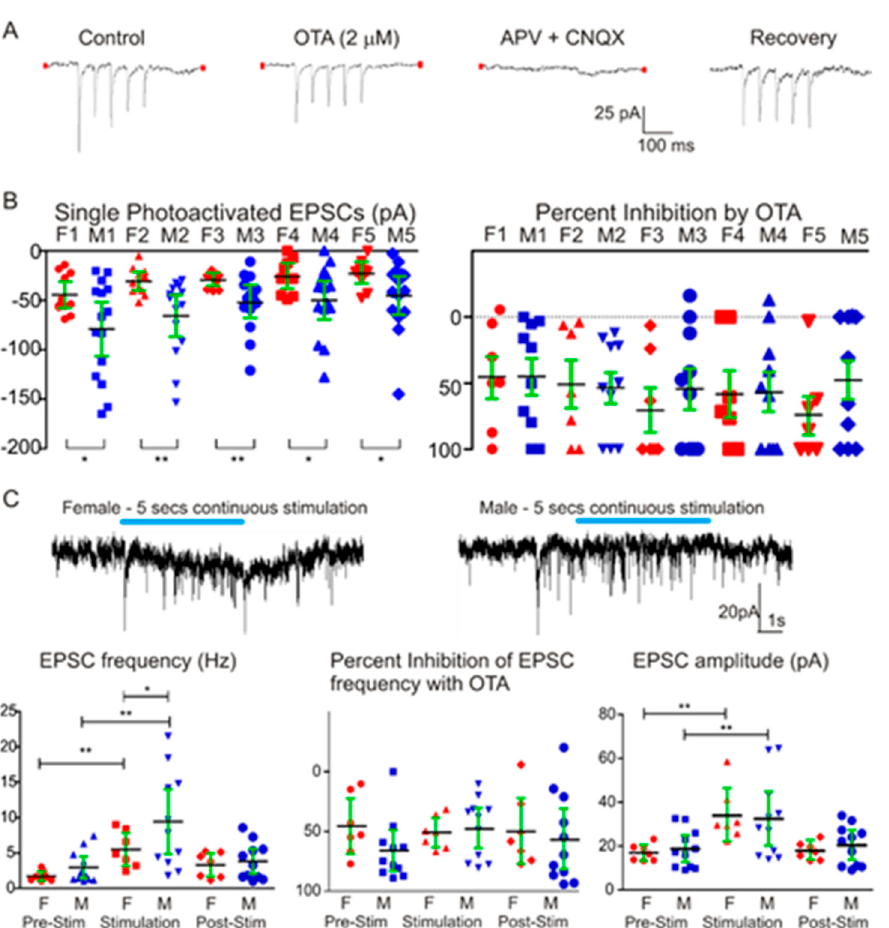
Figure 3. Photoactivation of PVN OXT ChR2 expressing fibers elicited postsynaptic excitatory currents in LC NA neurons that were greater in male compared to female animals. ( A ) Representative traces recorded in voltage clamp configuration from a LC NA neuron. The specific oxytocin receptor antagonist, OTA inhibited, while the AMPA and NMDA glutamate receptor antagonists—APV and CNQX, respectively—blocked photoactivated synaptic responses. This inhibition was reversible following washout of OTA, APV and CNQX. ( B ) The photostimulated EPSCs were significantly greater in males ( n = 15) than females ( n = 11) in all five consecutive photoactivations (five pulses, 1 msec/pulse, left). The percentage inhibition of evoked EPSCs by the oxytocin receptor antagonist, OTA, ( B , right) were not different between males and females. ( C ) Representative synaptic events prior to, during, and following a five second continuous photoactivation of ChR2 fibers in female (left) and male (right) LC NA neurons. EPSC frequency increased significantly in both males and females during the 5 s photostimulation. The facilitation of EPSC frequency was significantly greater in male than in female animals. OTA significantly inhibited the increase in EPSC frequency during the photoactivation, and this was not different in males compared to females. EPSC amplitude also increased during the photoactivation, and this augmentation of EPSC amplitude was similar in males and females. ** p < 0.01; * p <